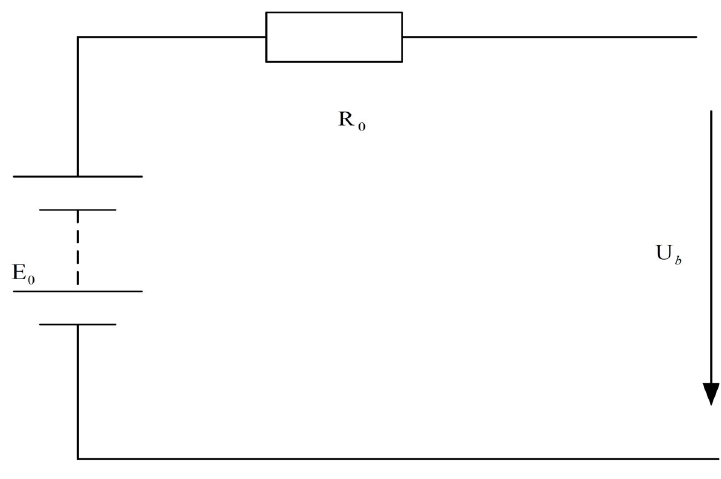
Figure 4. Power battery internal resistance model.